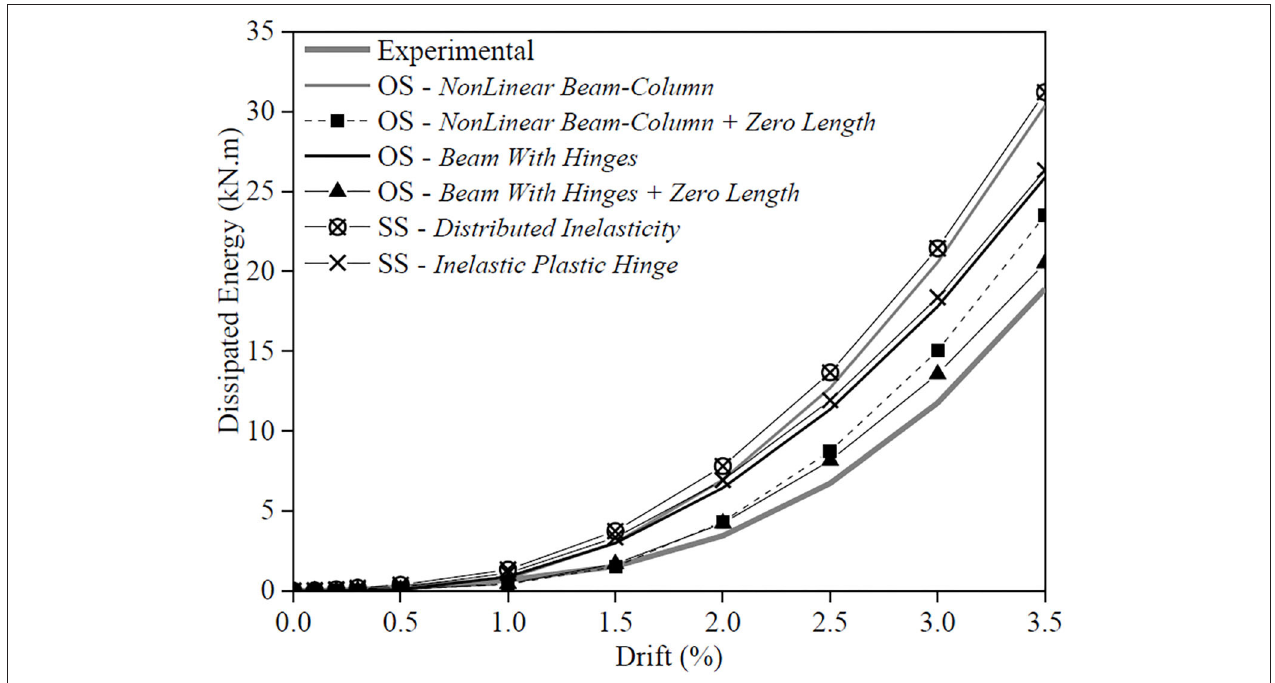
FIGURE 6 | Numerical and experimental dissipated energy evolutions of specimen CD.